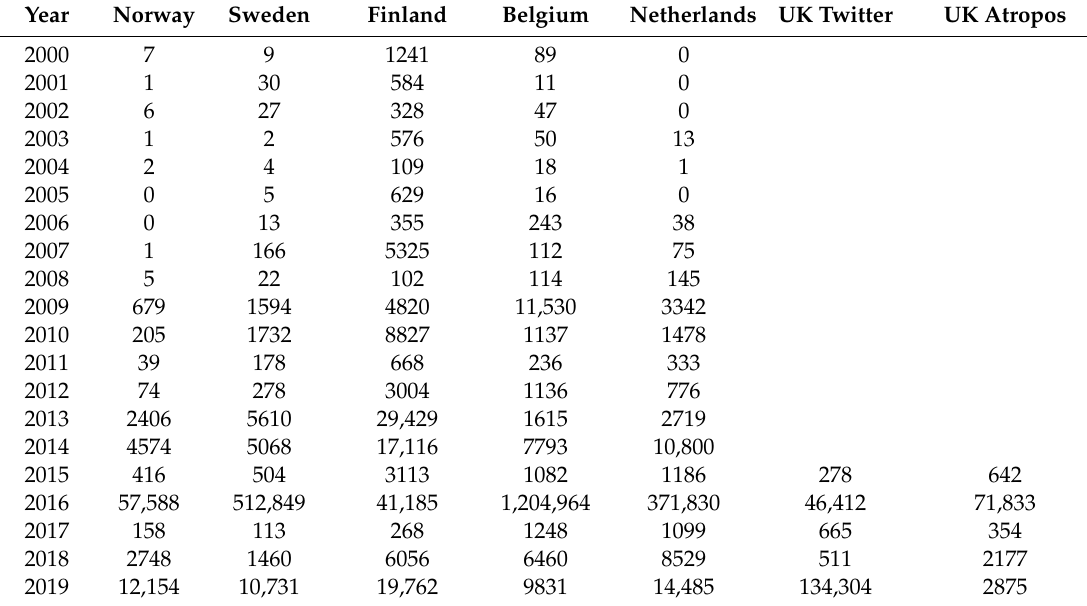
Table 4. Numbers of P. xylostella recorded on publicly available citizen science databases and Twitter across Northern Europe